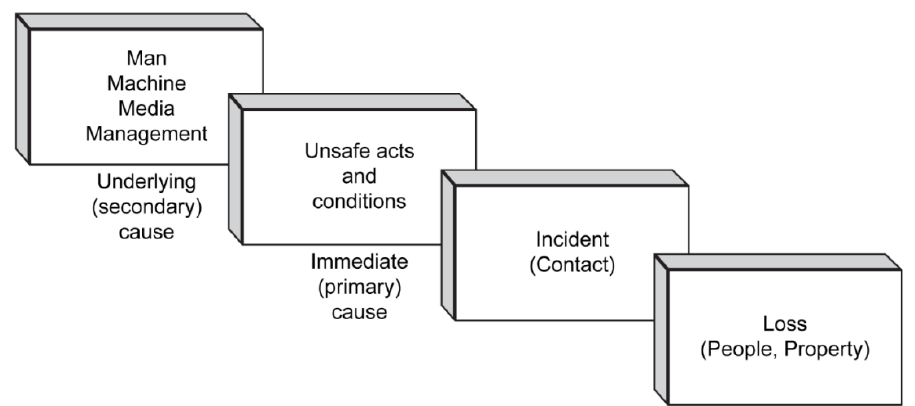
Figure 1. Domino sequence of accident causation theory (updated by author).